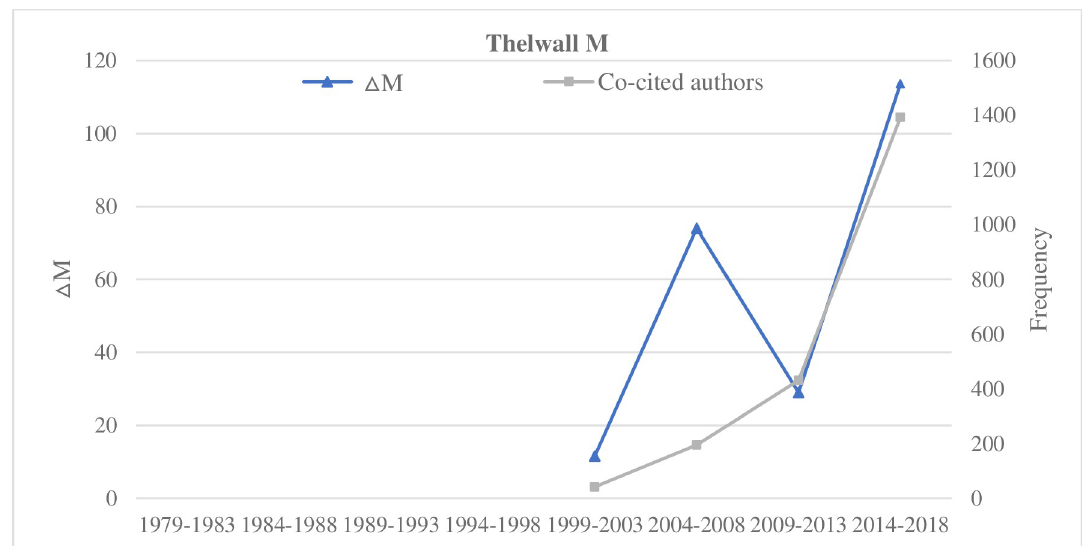
Fig 8. Indicators of the impact of Thelwall M.